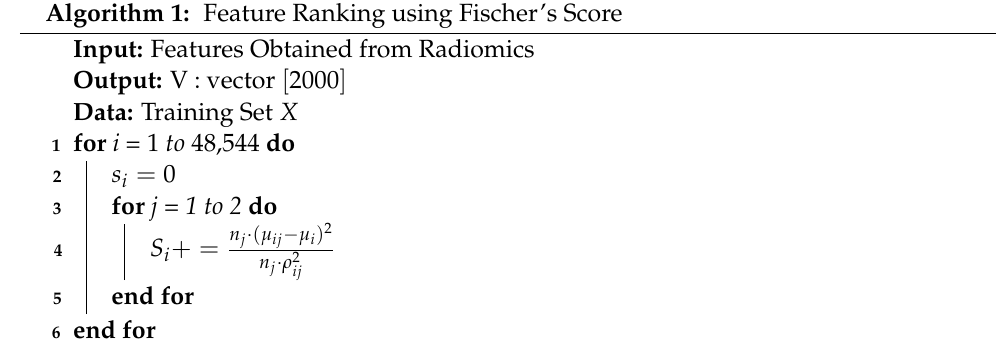
Algorithm 1: Feature Ranking using Fischer’s